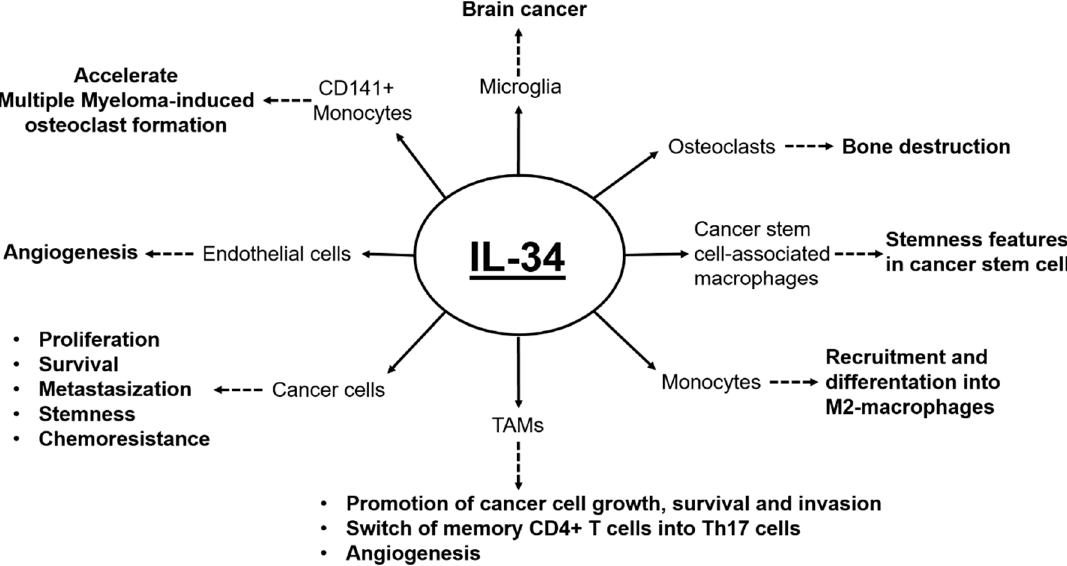
Figure 2. Overview of the tumor promoting e ff ects of IL-34 on its target cells. Solid arrows indicate the targets of IL-34. Dashed arrows indicate the IL-34-driven, target-related tumorigenic e ff